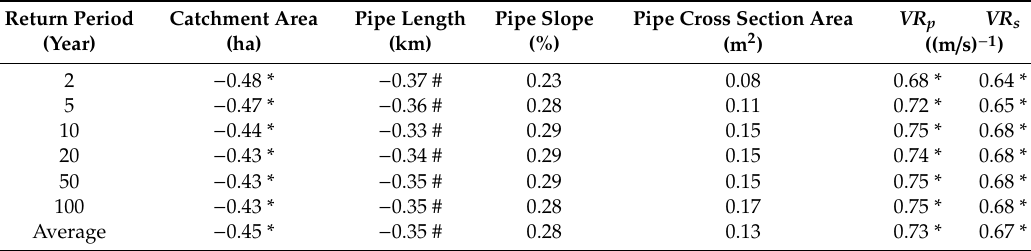
Table 3. Pearson correlation coe ffi cients between the DR and influential factors under six typical return periods. The correlation analysis is based on all 25 networks, using one network as a sample. “*” and “#” denote the confidence levels of 95% ( p -value 0.05) and 90% ( p -value 0.1), respectively. “ VR p ” and “ VR s ” are the Velocity Ratio using pipe slope and surface slope,